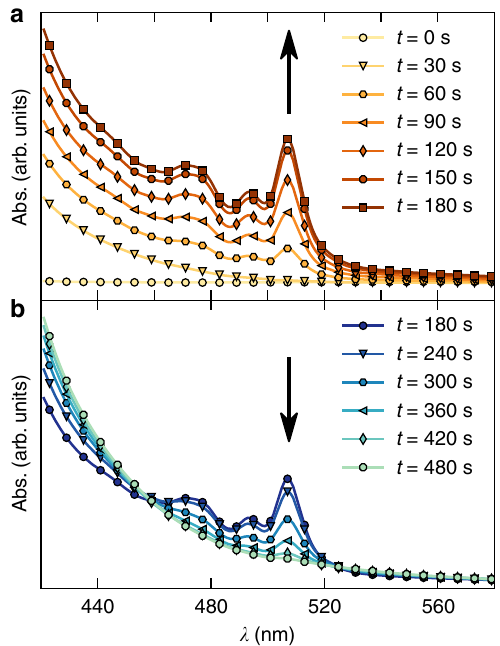
Fig. 2 KI-induced dehalogenation of 2 . The reaction was monitored by UV spectroscopy measured in a 1:1 mixture of THF:CH 3 CN at 20 °C. The fi rst measurement ( t = 0) was taken before the addition of KI. a Shows the time before the peak at 507nm has reached its maximum and b